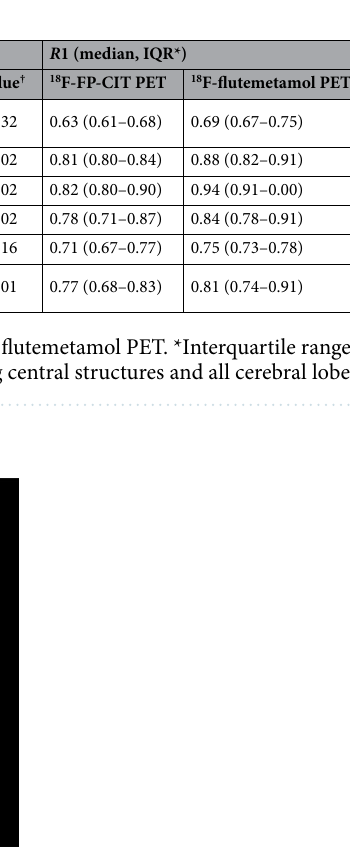
Figure 1. Representative images of early-phase PETs. The 18 F-FP-CIT SUVR image showed less uptake in cortical areas (white arrowheads in A ) than the 18 F-flutemetamol SUVR image (grey arrowheads in B ), while the central structures showed similar activity in the two PETs (white arrows in A and grey arrows in B